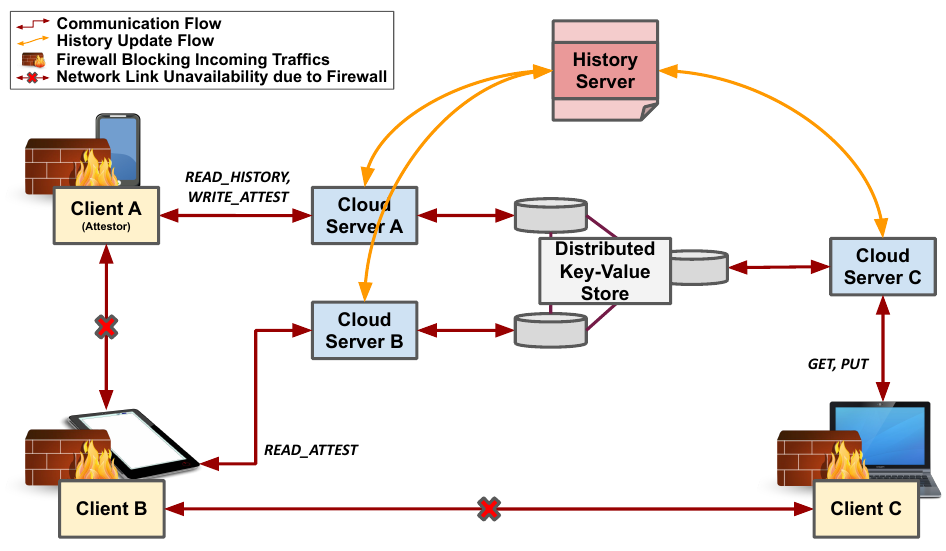
Figure 1. Target Environment of